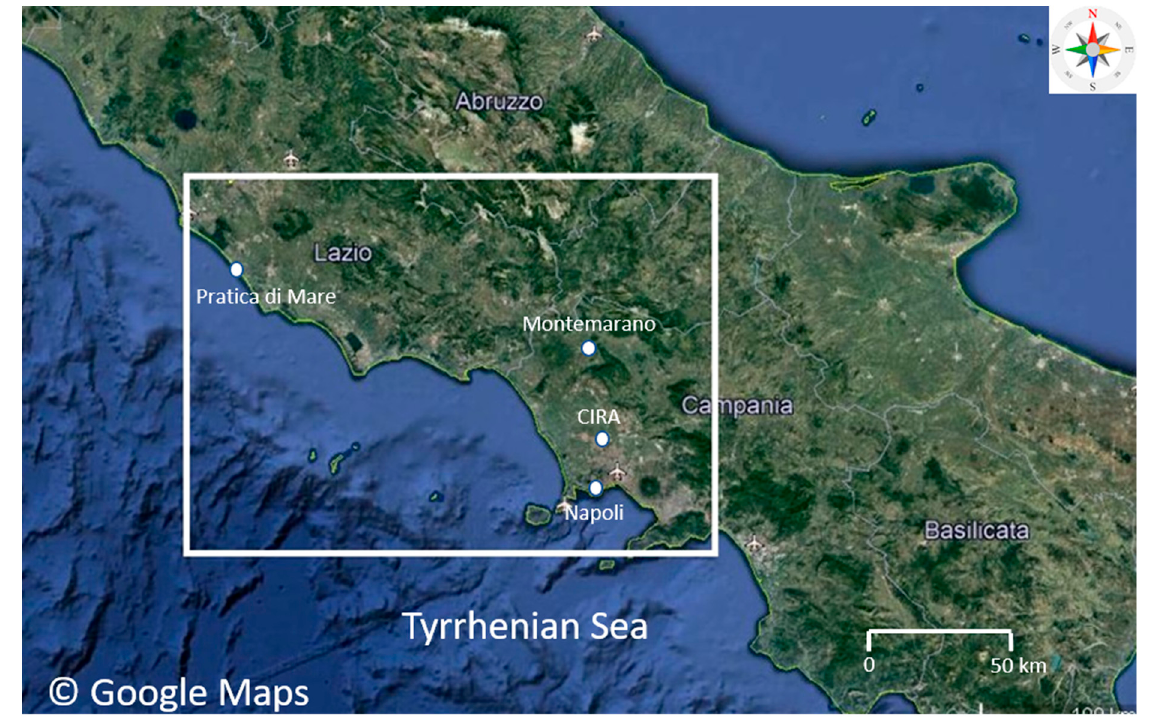
Figure 1. The computational domain considered, including northern Campania and southern Lazio regions. The locations of the observational stations are specified.